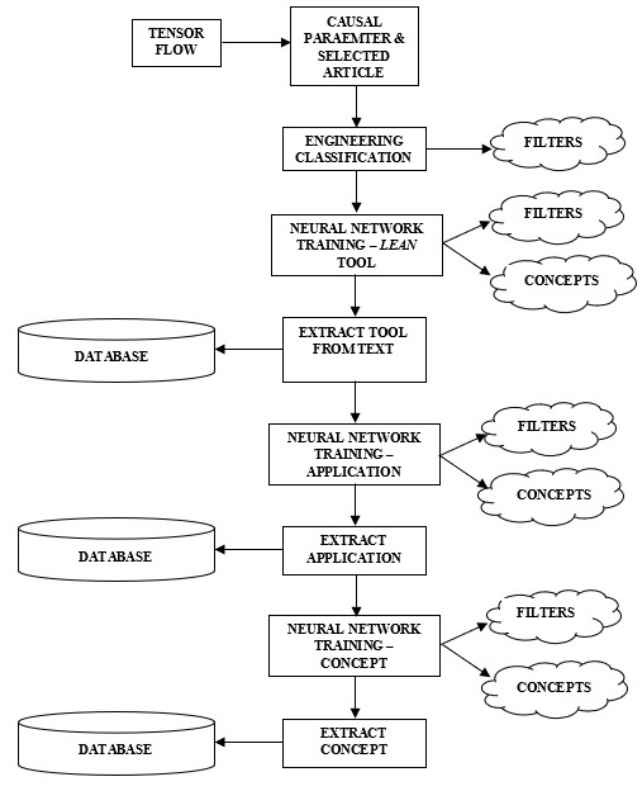
Figure 5. Representation of a neural network within the system.